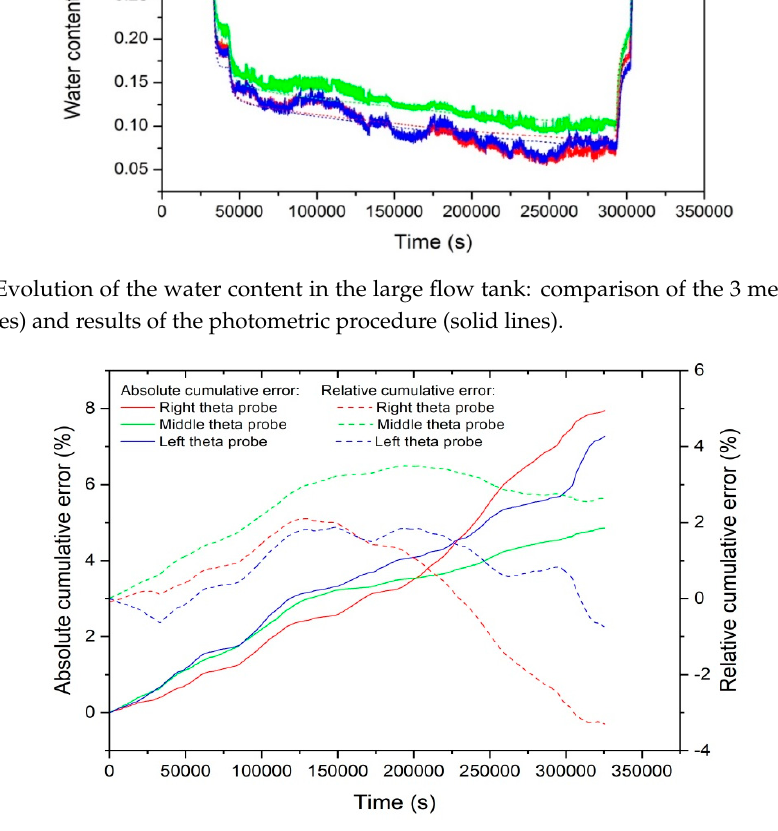
Figure 7. Evolution of cumulative error in water content in the large flow tank: absolute (solid lines, computed with Equation (11)) and relative (dashed lines, computed with Equation (12)) errors between measurements and computation.